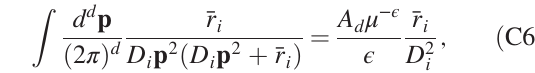
˜ ϕ ϕ 3 1 , and (e) 1 . To this i